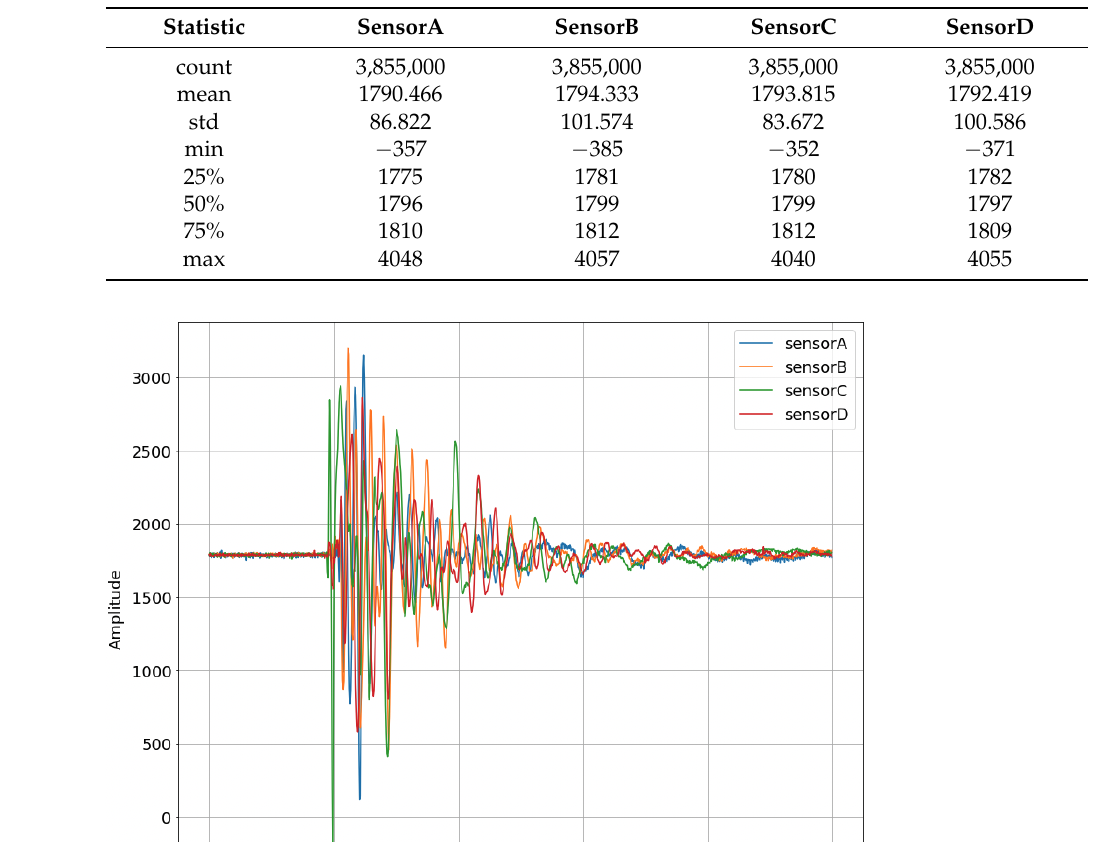
Table 4. Descriptive statistics for the four PZT sensor measurements.